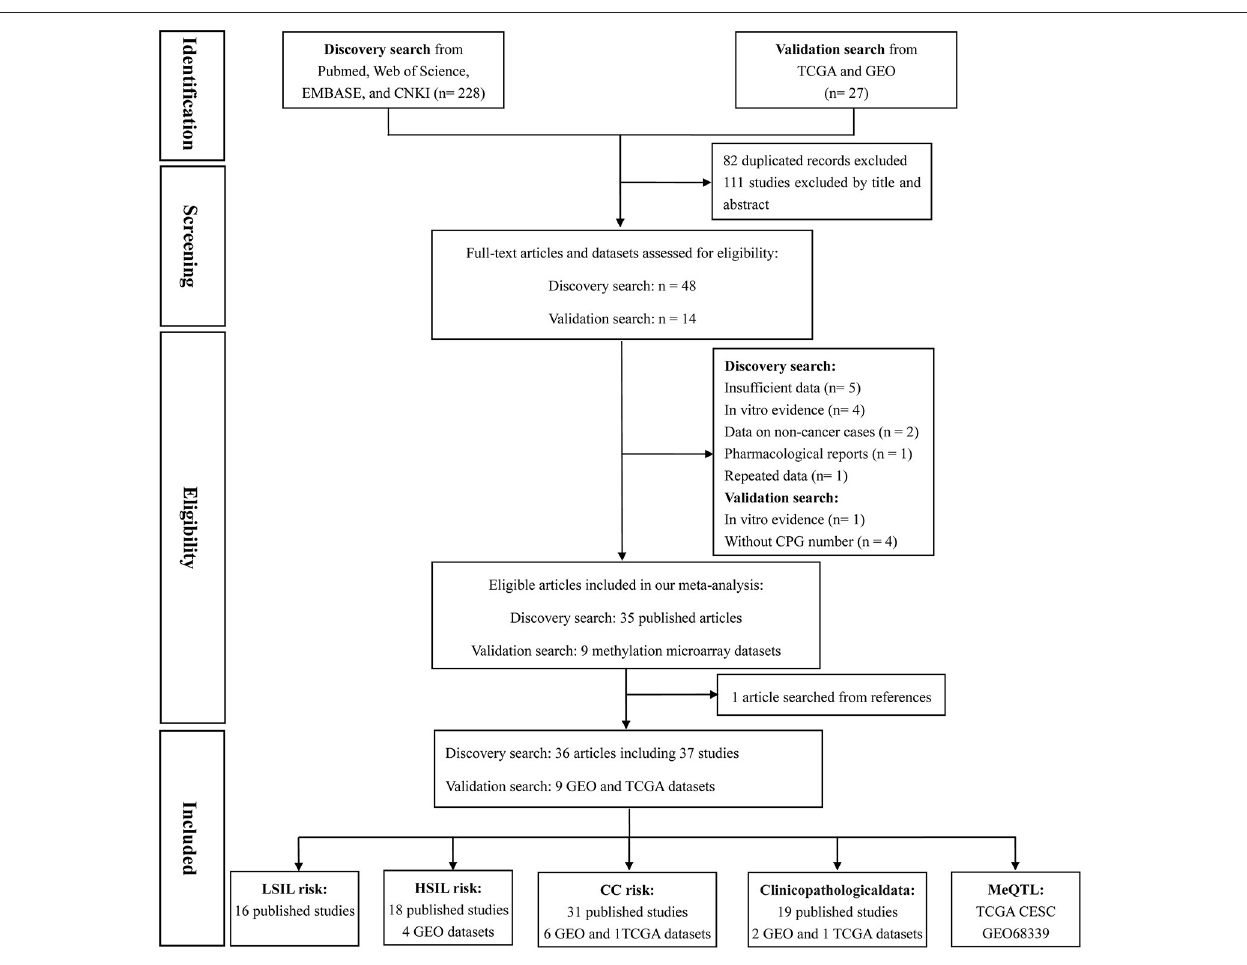
FIGURE 1 | Flow chart of study selection